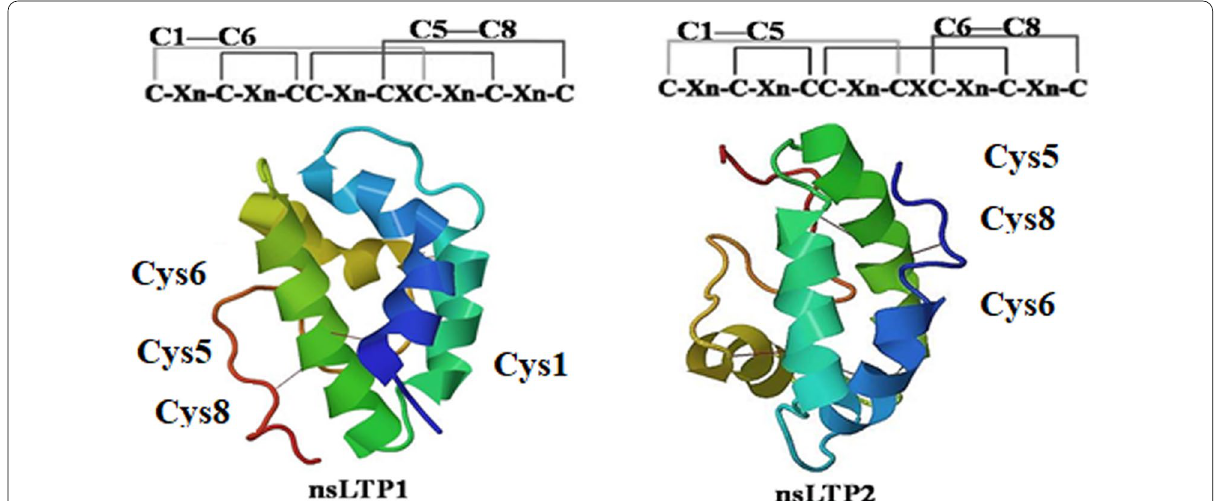
Fig. 1 Schematic representation of differential disulphides’ connection pattern and tertiary structure of well structurally characterized non-specific lipid transfer protein (nsLTP) of type1 and type2. Line joining represents different positions involved in disulphide bridge formation. In type1, cyst-1 connects with cys-6 and cys-5 with cys-8, whereas in type2, cys-1 with cys-5 and cys-6 with cys-8. Tertiary model structure of nsLTP1 and